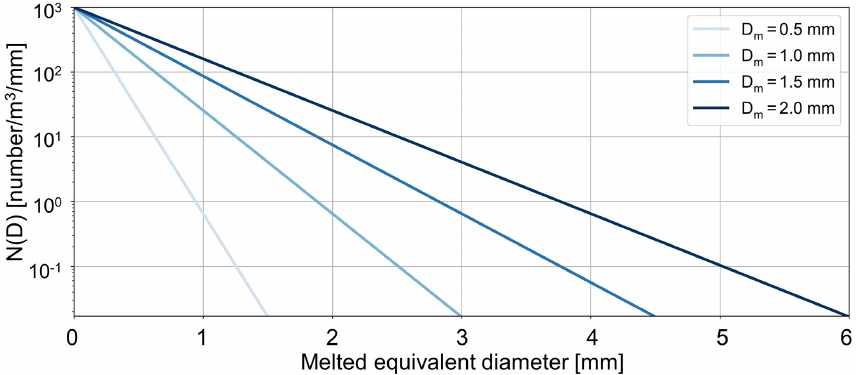
Figure 7. Gamma PSD for different values of D m , AR = 1 . 67, N w = 1 × 10 3 , and µ = 0.